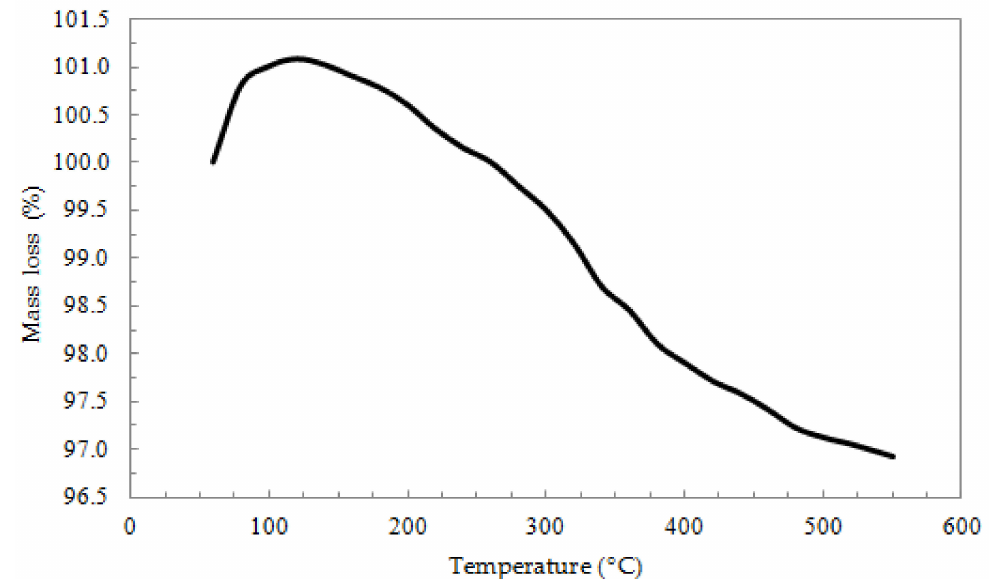
Figure 1. TGA of oxidized exfoliated graphite nanoplatelets (ox-xGnP).